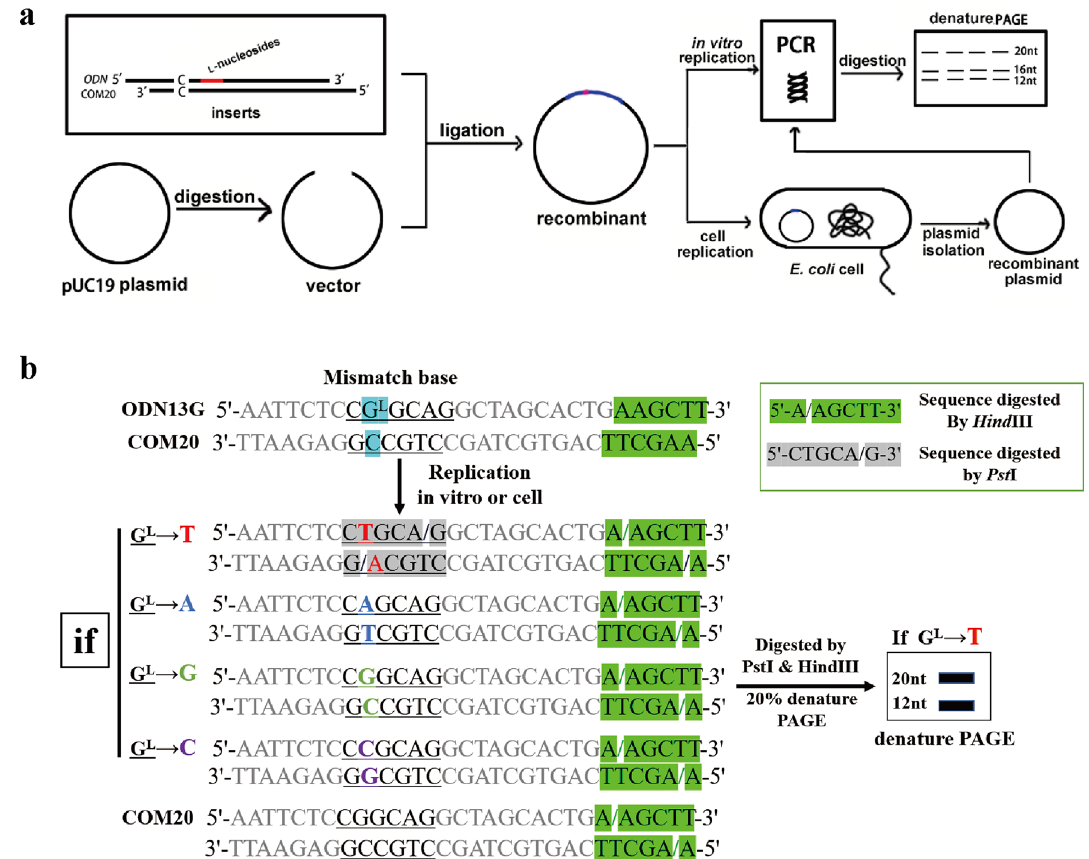
Figure 1. Schematic diagram of restriction endonuclease mediated assay for study on replication of DNA containing